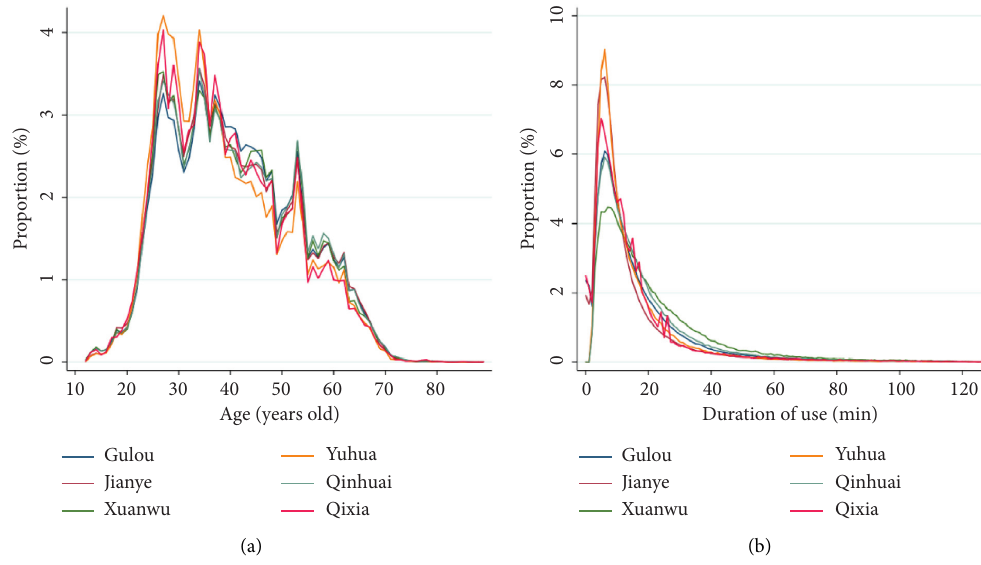
Figure 1: Distribution of (a) age and (b) use duration of bicycle-sharing